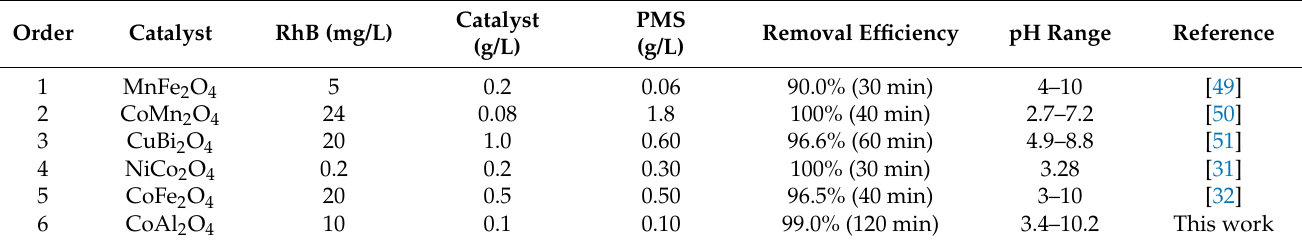
Table 1. Comparison of RhB degradation by bimetallic oxides through PMS